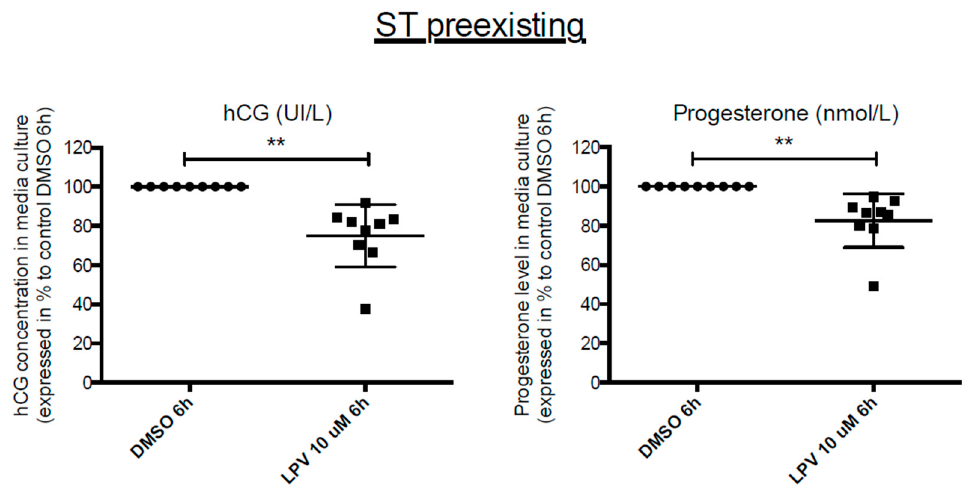
Figure 9. Brief incubation with Lopinavir decreases hCG and progesterone secretion both in VCT and ST cells . Cytotrophoblasts isolated and purified from term placenta were cultured for 72 h in complete DMEM to allow ST formation before incubation for 6 h with LPV 10 µM or DMSO. hCG and progesterone concentrations were measured by immuno-analysis in culture supernatant. Results are expressed as the mean +/ − SEM of n = 11 independent experiments. ** p < 0.01 vs. DMSO, two-tailed paired no parametric student t -test.